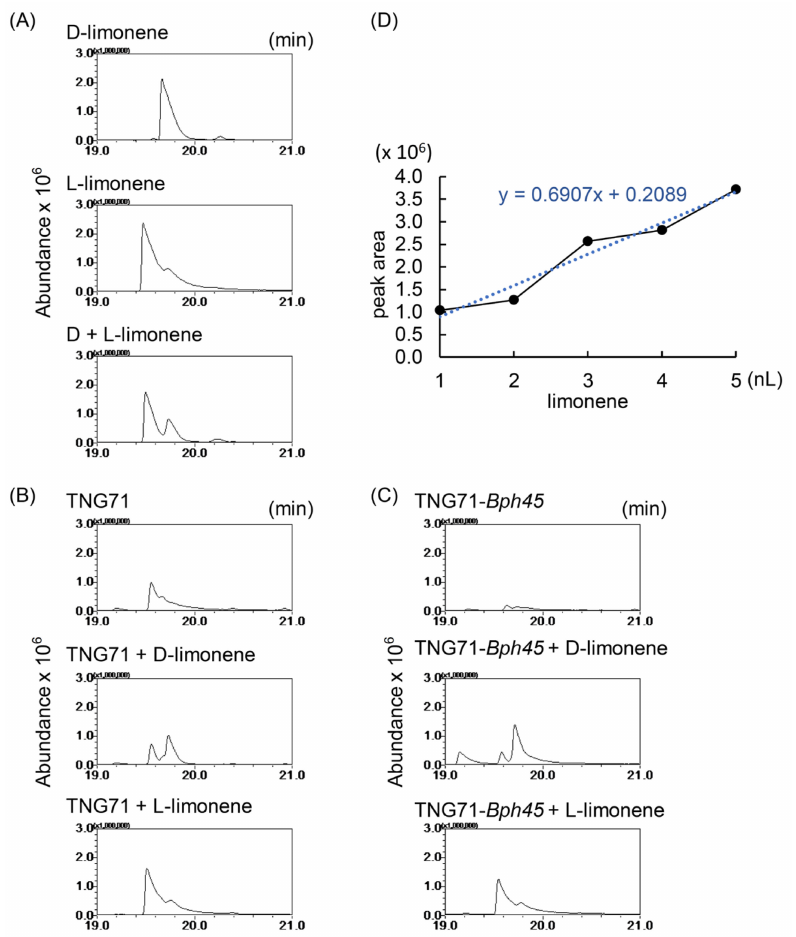
Figure 4. Analysis of chirality and amount of limonene emitted by rice plants. VOCs emitted from 5 g of fresh rice tissues were collected for 16 h at room temperature using an SPME probe and then analyzed by GC-MS. To characterize the form of limonene in rice, 3.125 nL of the (D)-form or (L)-form authentic limonene standard alone ( A ), together with 5 g fresh leaves of TNG71 ( B ), or together with 5 g fresh leaves of TNG71- Bph45 ( C ), was absorbed by the SPME probe then resolved on a Cyclodex-B column. To quantify the amount of limonene in rice, various amounts of the (L)-form of limonene (1–5 nL) absorbed by the SPME probe were resolved on a Rtx-5MS column ( D ). The amount of limonene in rice was calculated by interpolation. The black dots indicate the five standard concentrations used and the blue line indicates its linear regression